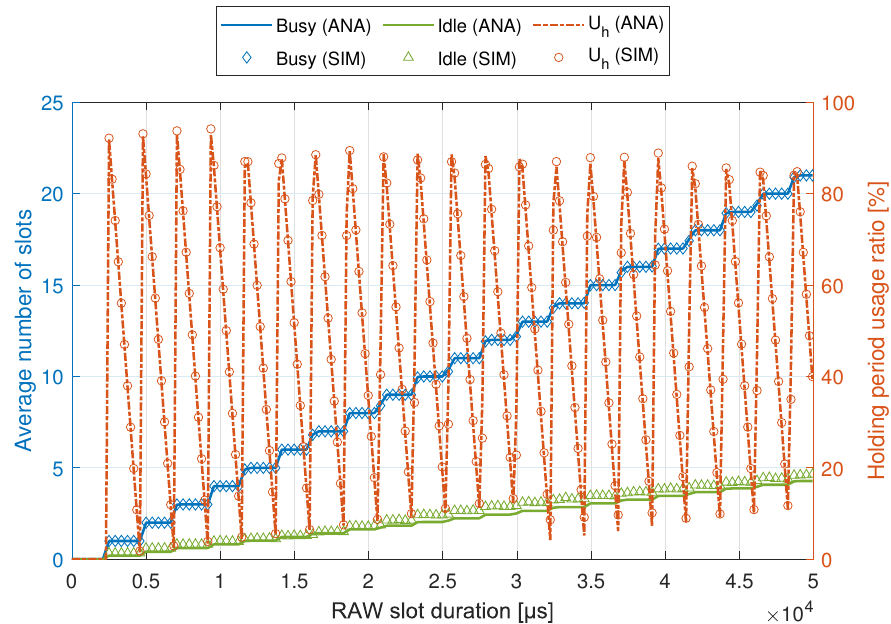
Figure 6. Average number of busy and idle slots, and the holding period usage ratio within the RAW slot interval, with channel capture threshold z =